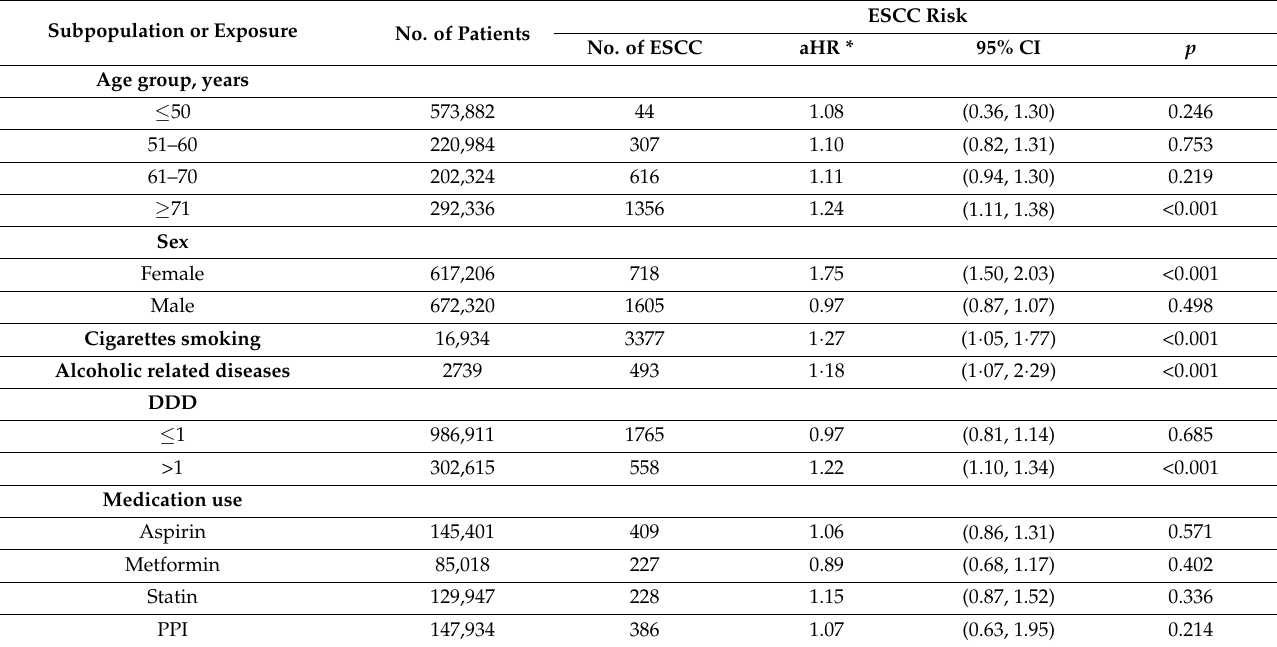
Table 4. Sensitivity analyses of ESCC incidence–AH use